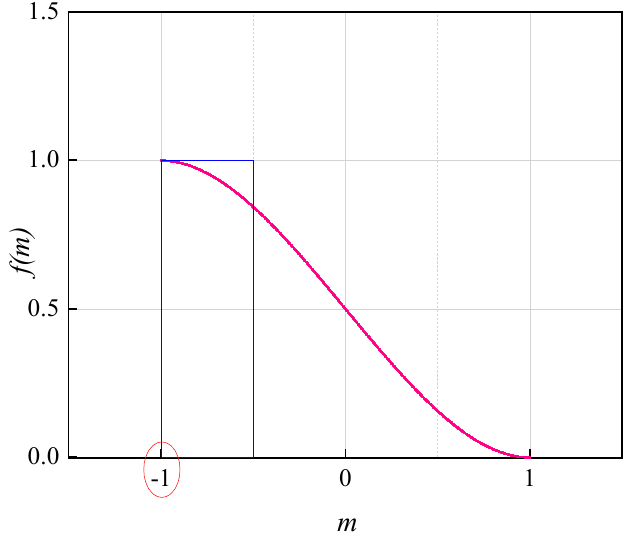
Figure 2. Functional image of contact angle and critical nuclear energy.